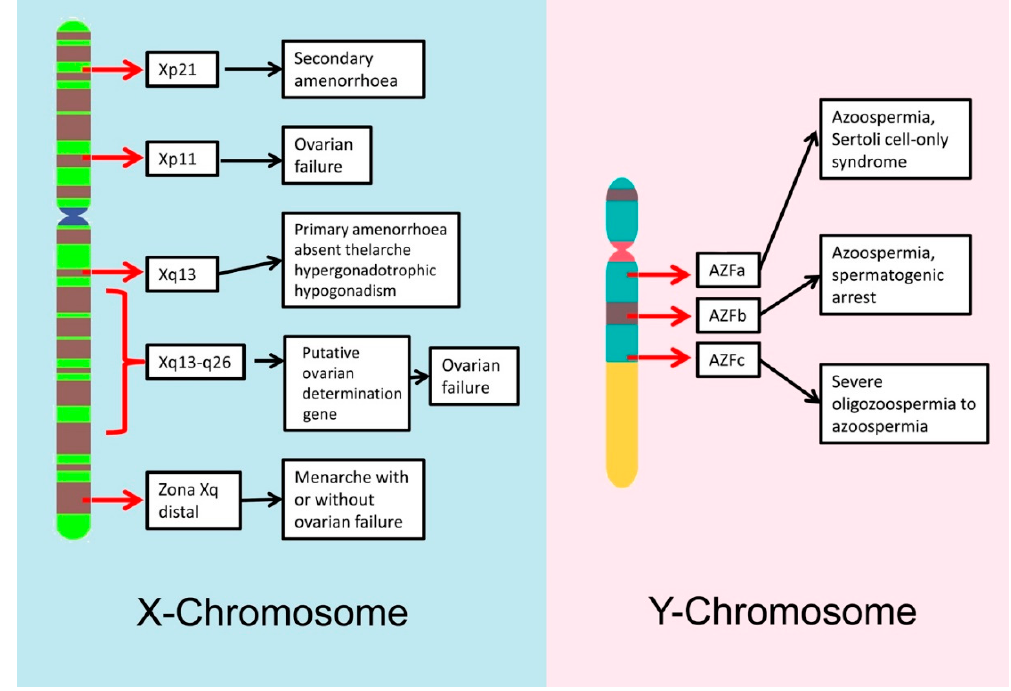
Figure 1. Schematic overview of the main regions at the sex chromosomes where microdeletions are directly related with infertility.